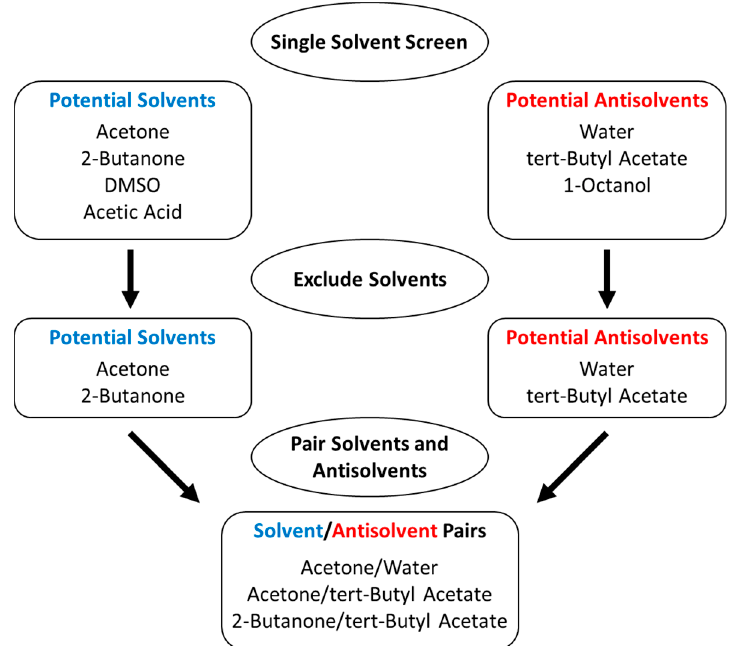
Figure 2. Graphical representation of the literature-based solvent/antisolvent screen for lovastatin.